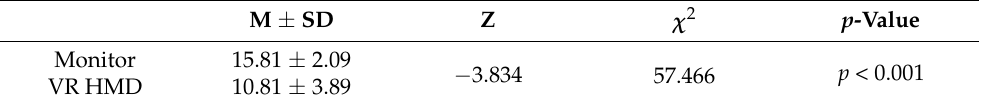
Table 4. Comparison of the blink rate in the monitor environment and VR HMD environment ( n = 21).